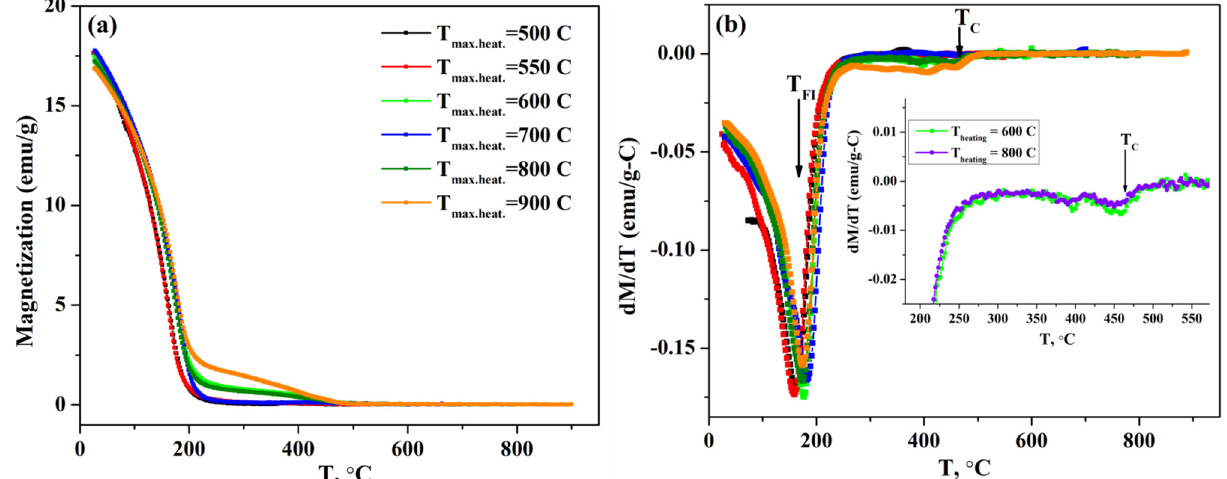
Figure 2. ( a ) Temperature–dependent magnetization of the Fe 1.1 Mn 1.9 O 4 nanoparticles heated to 500 ≤ T max.heat. ≤ 900 ◦ C; ( b ) derivative of M with respect to temperature. The inset in ( b ) shows dM/dT on an enlarged scale near T C for the samples heated to 600 and 800 ◦